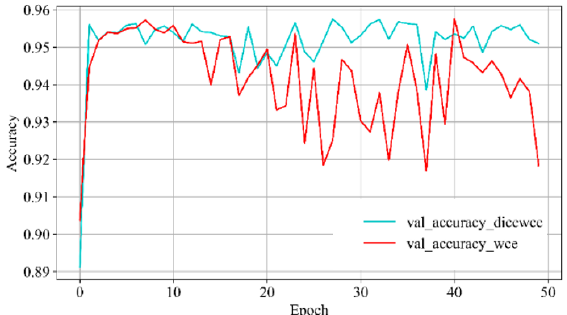
Figure 4 . Accuracy comparison between two models trained using cross entropy and dice loss functions.